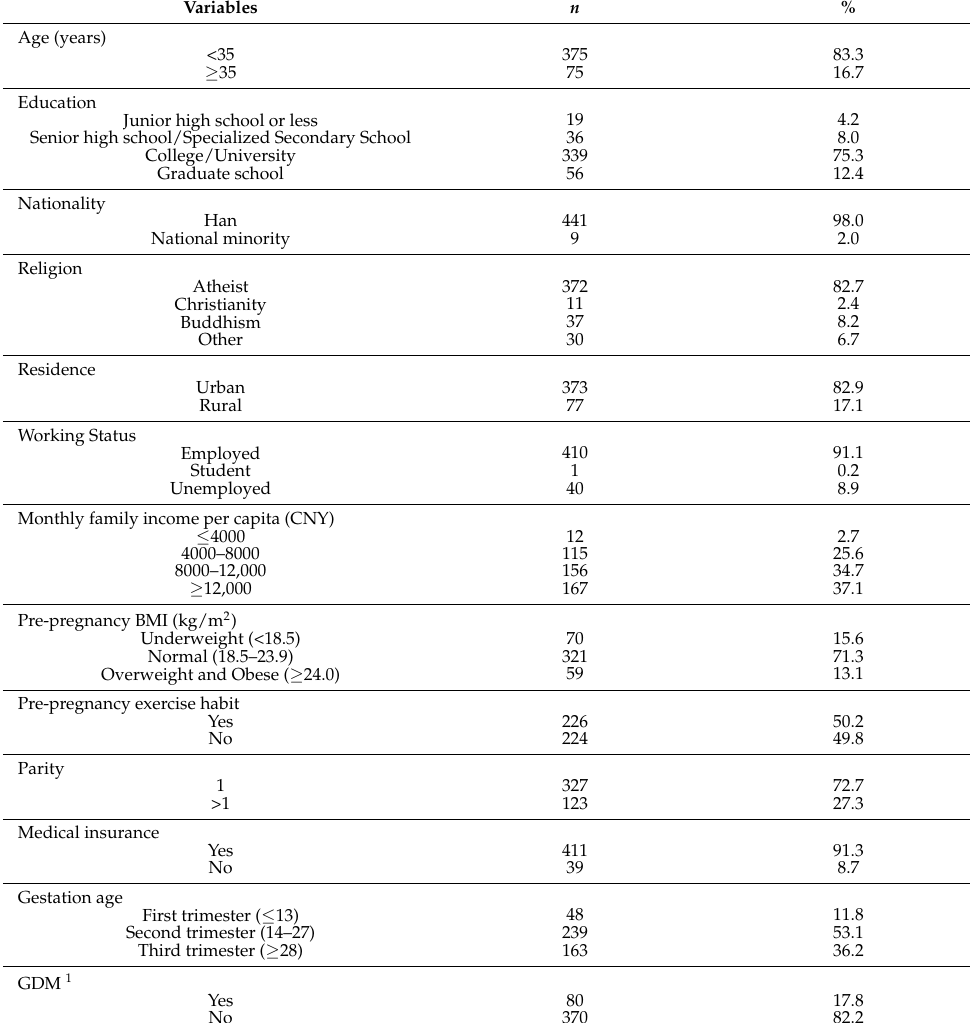
Table 1. Characteristics of participants ( n =